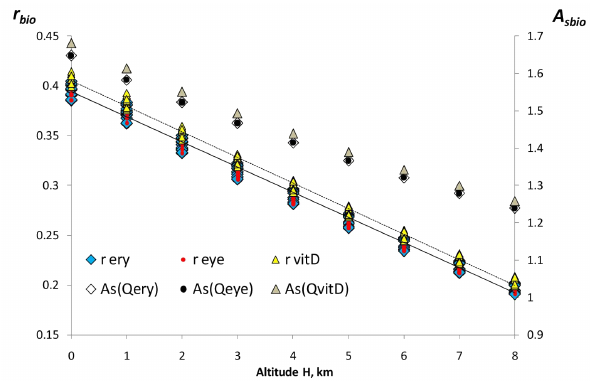
Figure 6. The dependence of r bio with the altitude for different BAUVR from accurate model simulations for a variety of geophys- ical parameters (left axis) and maximum A S effects due to changes in surface albedo from S = 0 at H = 0km to S = 1 at level H (right axis). The r bio regressions are shown in dashed line. Note, that the (H) is the same as for r Q (H) . The co- regression line for r Q eye ery efficients of the regression equations and the ranges of the input parameters at H = 0 are given in Table 2.